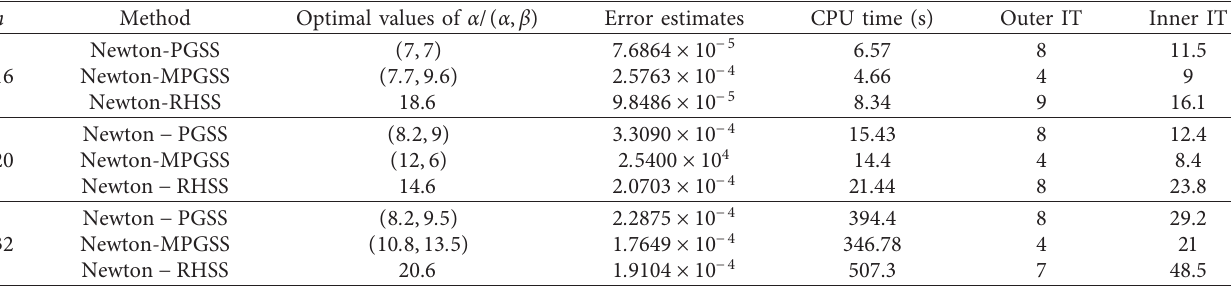
Table 3: Numerical results of inexact methods for v � 0.1 and η � 0.2.